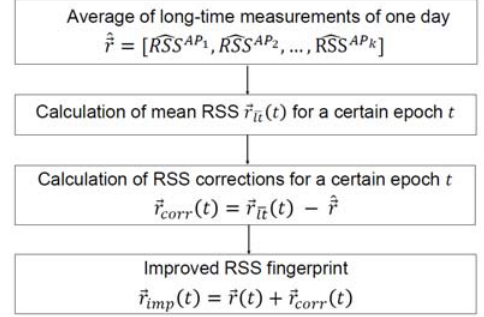
Figure 9. Flowchart for the derivation of RSS corrections for